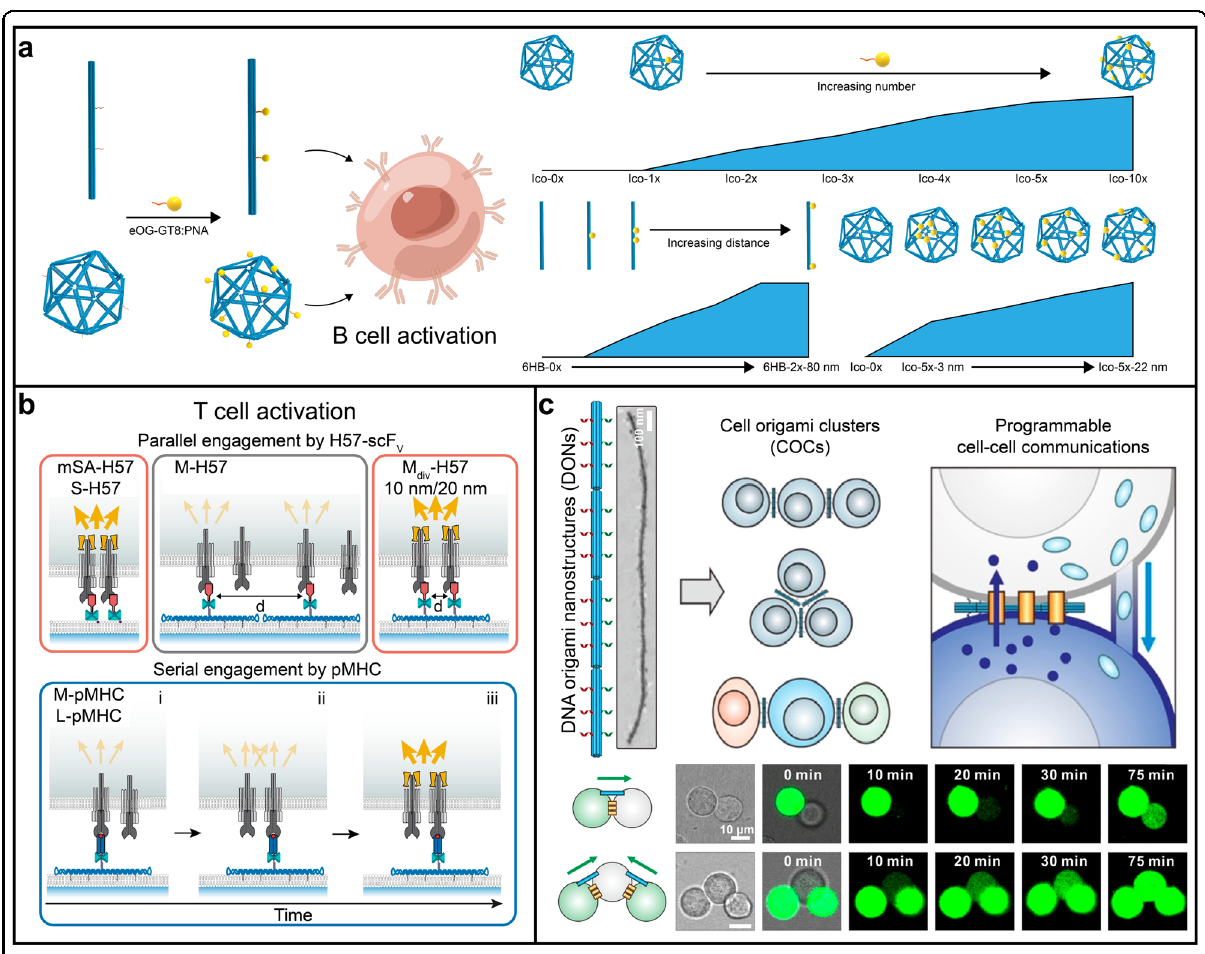
Fig. 5 Directing the behavior of cells by higher-order DNA origami structures. a Antigen-DNA hybrid NPs for studying the role of nanoscale antigen organization on B-cell activation. eOG-GT8 antigens are patterned on two DNA origami scaffolds into different spatial arrangements to investigate the impact of the spatial distribution of antigen on B-cell activation. b A laterally mobile DNA origami platform functionalized with antigens for exploring the mechanism of T-cell activation by pMHCs. (Reproduced with permission 156 , Copyright 2021, Proceedings of the National Academy of Sciences). c DNA origami structure-directed cell ‒ cell communication. DNA origami structures are used to direct the cell ‒ cell communications between different cells in de fi ned modes. (Reproduced with permission 165 , Copyright 2020, American Chemical